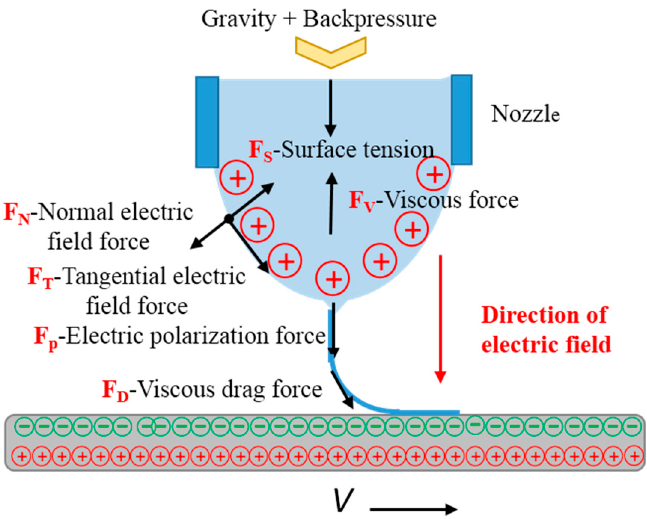
Figure 1. Schematic diagram of a continuous cone-jet deposition based on high-voltage electric field.